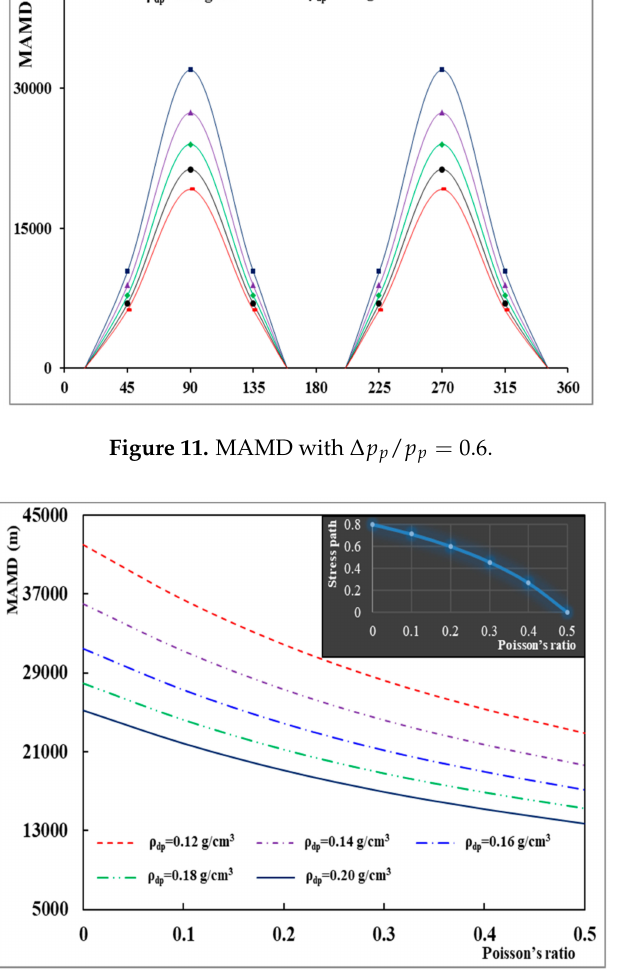
Figure 12. Effect of Poisson’s ratio on the